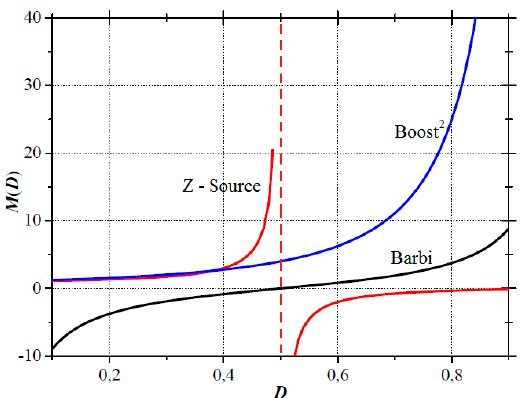
Figure 2. Ideal static transfer function M(D) of different converters.